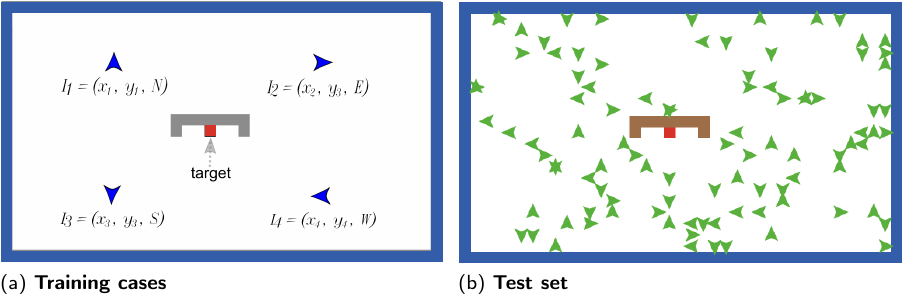
Figure 5. ( a ) A simple navigation task showing a small set of possible cases that could be used as a training set to reach the target (the red square at the center). ( b ) A set of 100 cases as the test set fixed for all the